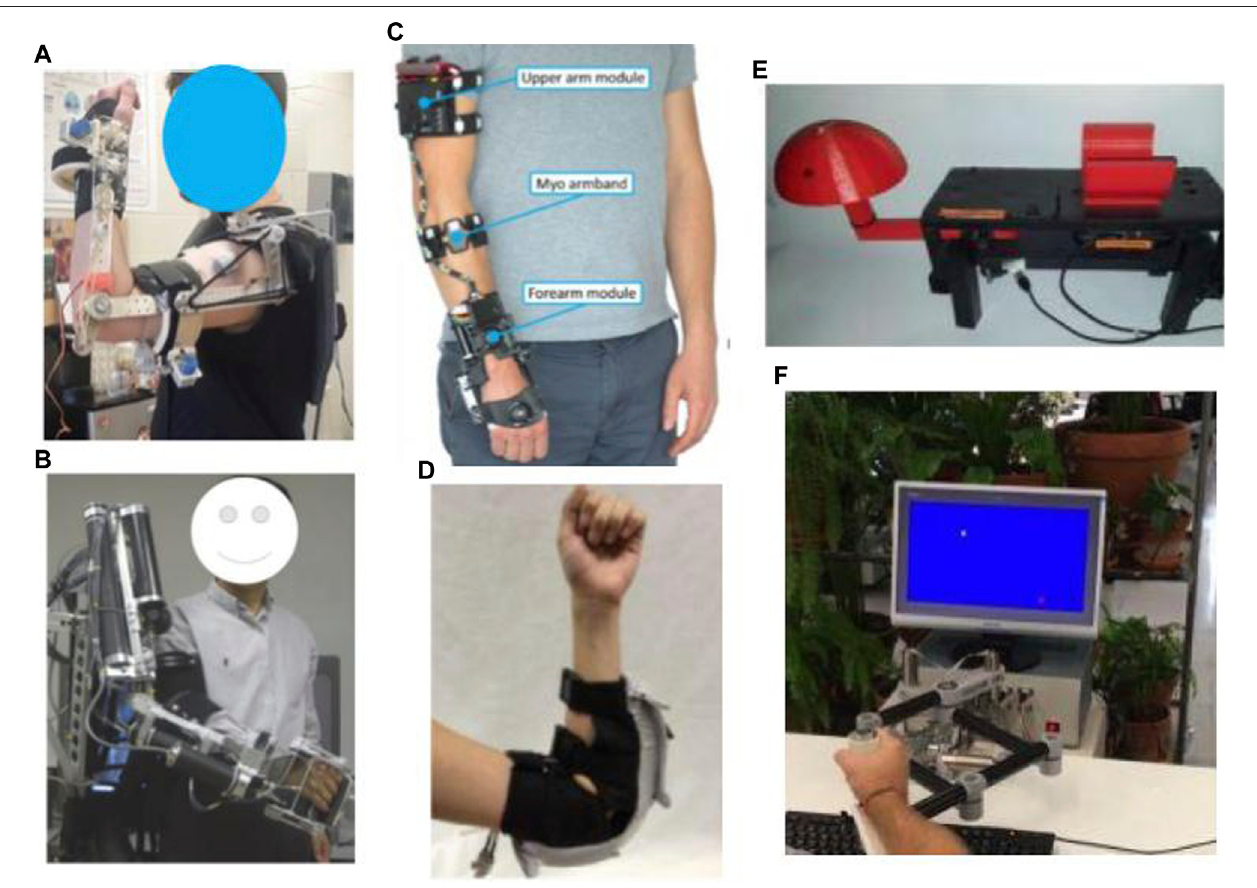
FIGURE2| Roboticexoskeletonandend-effectordevicesforhome-basedupper-limbrehabilitation: (A) SpringWear(ChenandLum,2018), (B) RUPERT(Tuetal., 2017), (C) eWrist (Lambelet et al., 2020), (D) Soft robotic elbow sleeve (Koh et al., 2017), (E) Portable device for wrist rehabilitation (Ambar et al., 2017), and (F) HomeRehab (Díaz et al.,